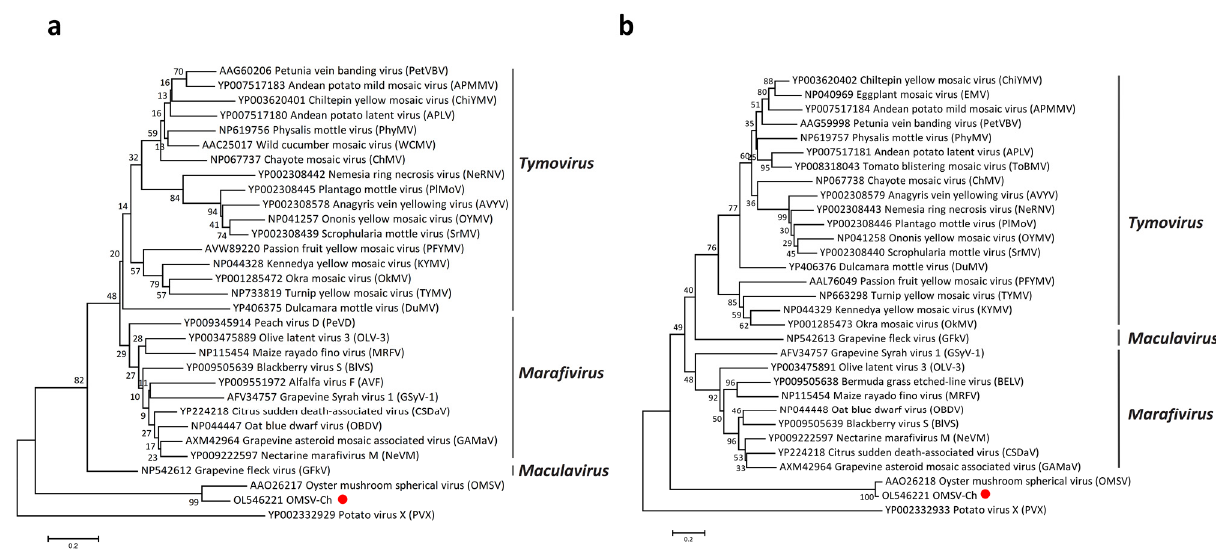
Figure 3. Phylogenetic analysis of the OMSV-Ch replication protein ( a ) and coat protein ( b ) with corresponding proteins of tymoviruses, marafiviruses, and maculaviruses. The OMSV-Ch sequence from the present study is marked with a red dot. Potato virus X (PVX) was used as an outgroup.